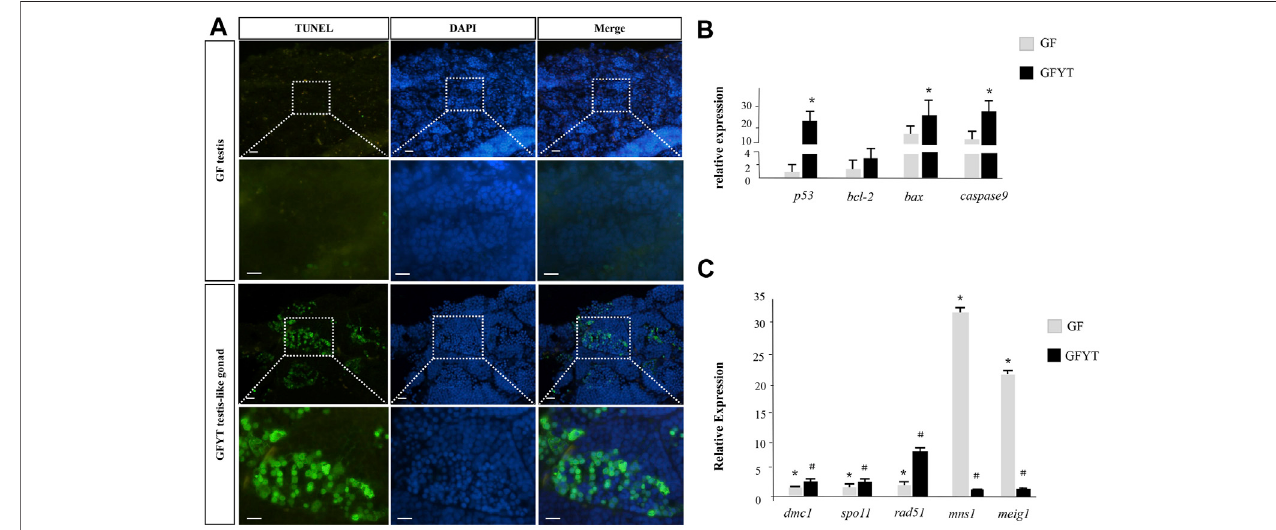
FIGURE5| Apoptosisassayandspermatogenesis-relatedgeneexpressioninthetestisofGFandGFYThybrids. (A) TUNELanalysisofthetestisofGFandtestis- like gonad of GFYT hybrids, Bar = 20 μ M. (B) Real-time PCR quanti fi cation of p53 , bcl-2, bax , and caspase9 . (C) Real-time PCR quanti fi cation of dmc1 , spo11 , rad51 , mns1 , and meig1 . Columns labeled with different symbols (# or *) mean signi fi cant difference ( p < 0.05).